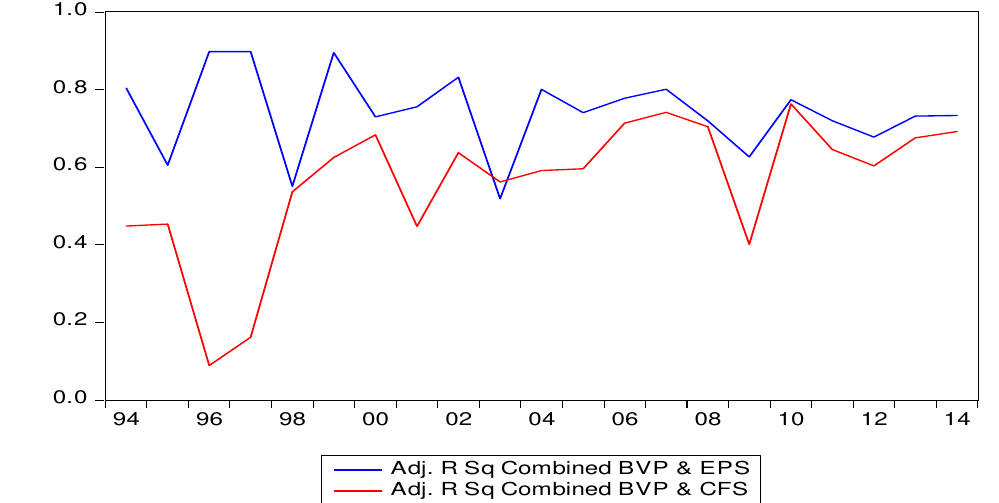
Fig. 2. Graphical view of the value relevance of combined book value and cash flow and the value relevance of combined book value and